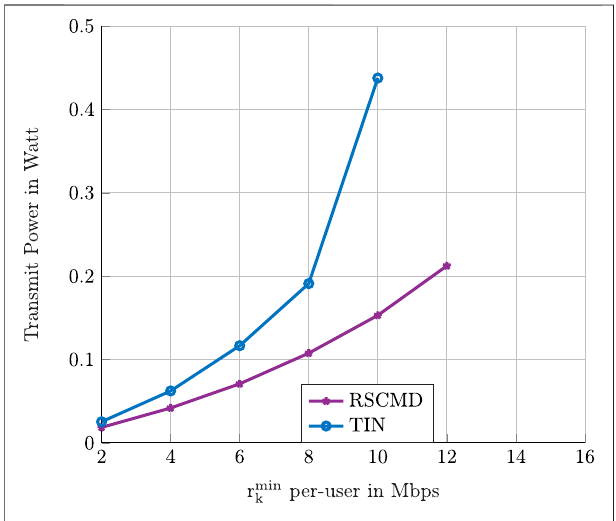
FIGURE 3 | The optimal value of the optimization problem (P 6 ) as a function of the deterministic required QoS per user.